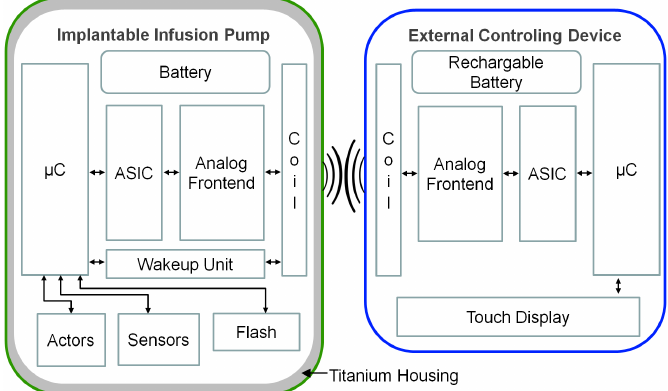
Figure 11. Block diagram of the complete electronics of the implantable infusion pump system, with the IIP on the left side and the ECD on the right side. The main transmission components are the micro-controller ( µ C), the QPSK-ASIC, the analog frontend circuit and the coil. Additionally, the IIP has sensors, actors, a flash memory and a wake-up unit. The ECD has a touch display, where all commands are handled. Both devices are powered by